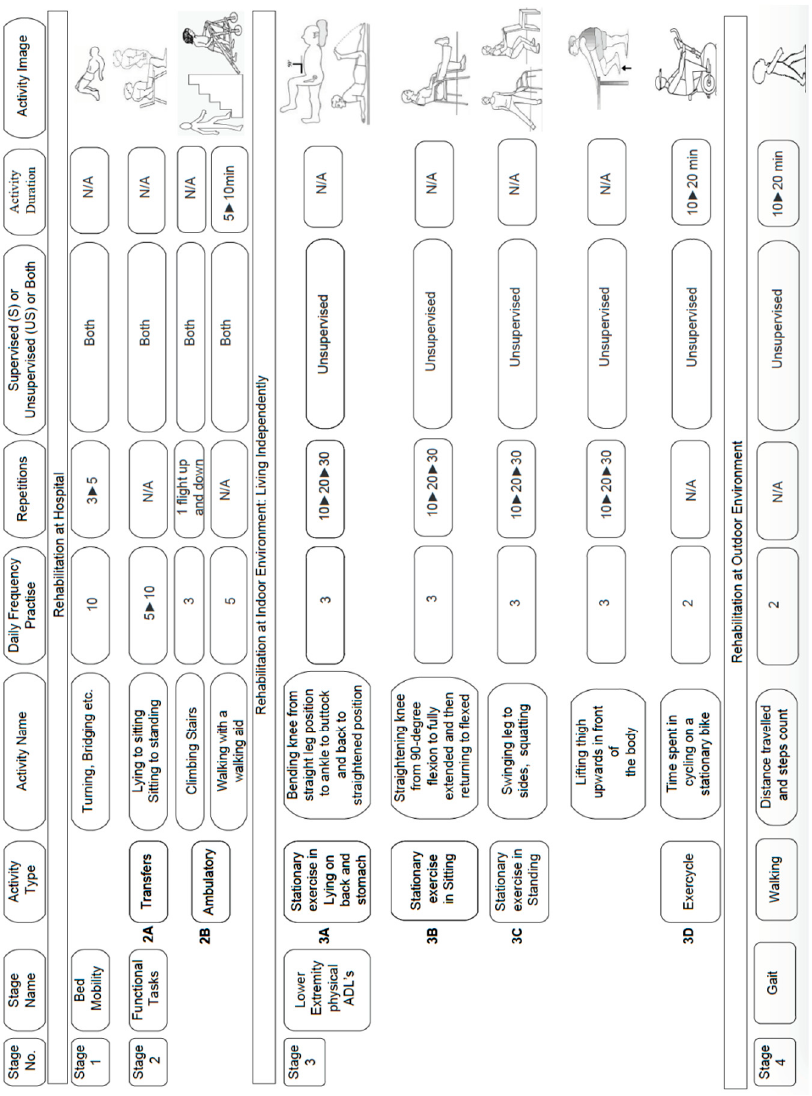
Figure 1. Post-operative hip fracture rehabilitation model illustrating the significance of involved activity movements across different stages of hospitalization, indoor living, and outdoor activities